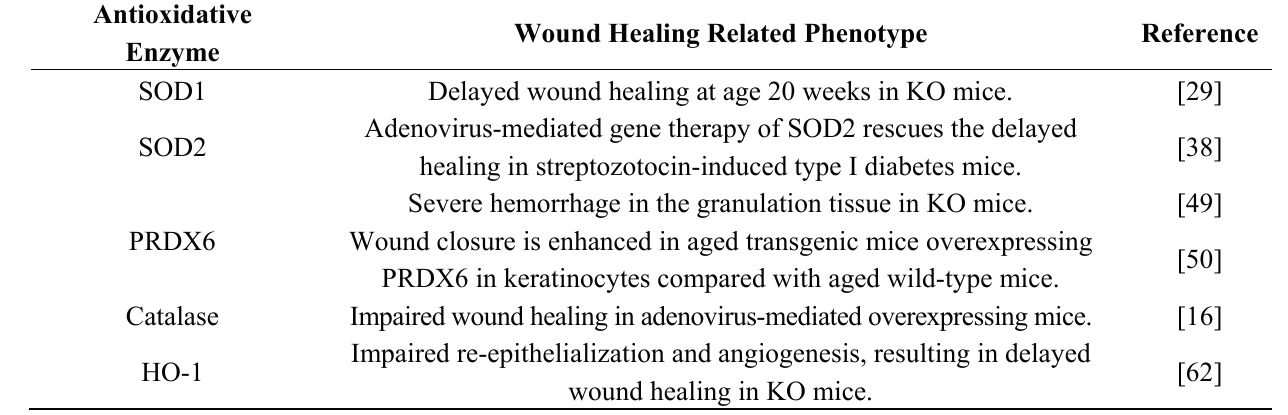
Table 1. Wound healing related phenotypes in genetically modified